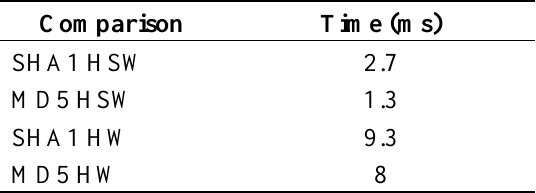
Table 9. MD5 versus